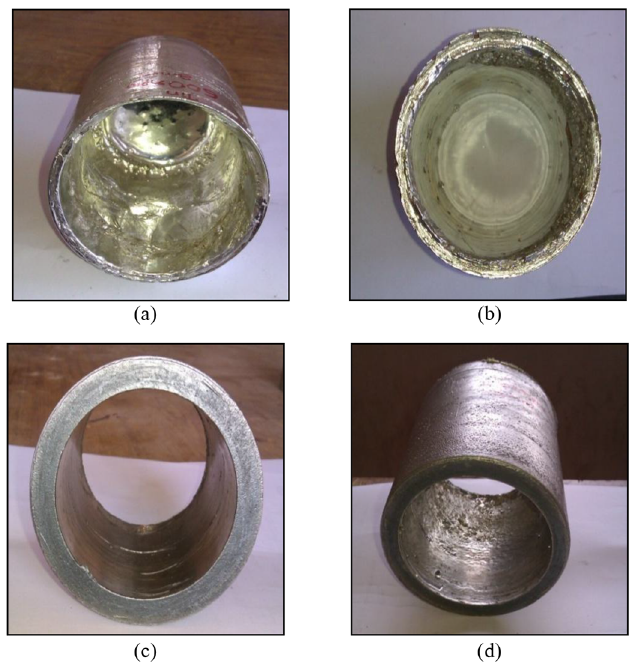
Fig. 2. Casting of 8 mm thick Tin rotated at a speeds of